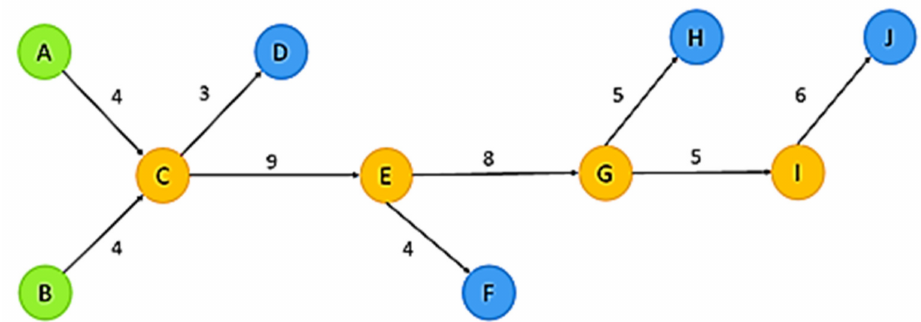
Figure 1. Example of main path analysis based on SPLC